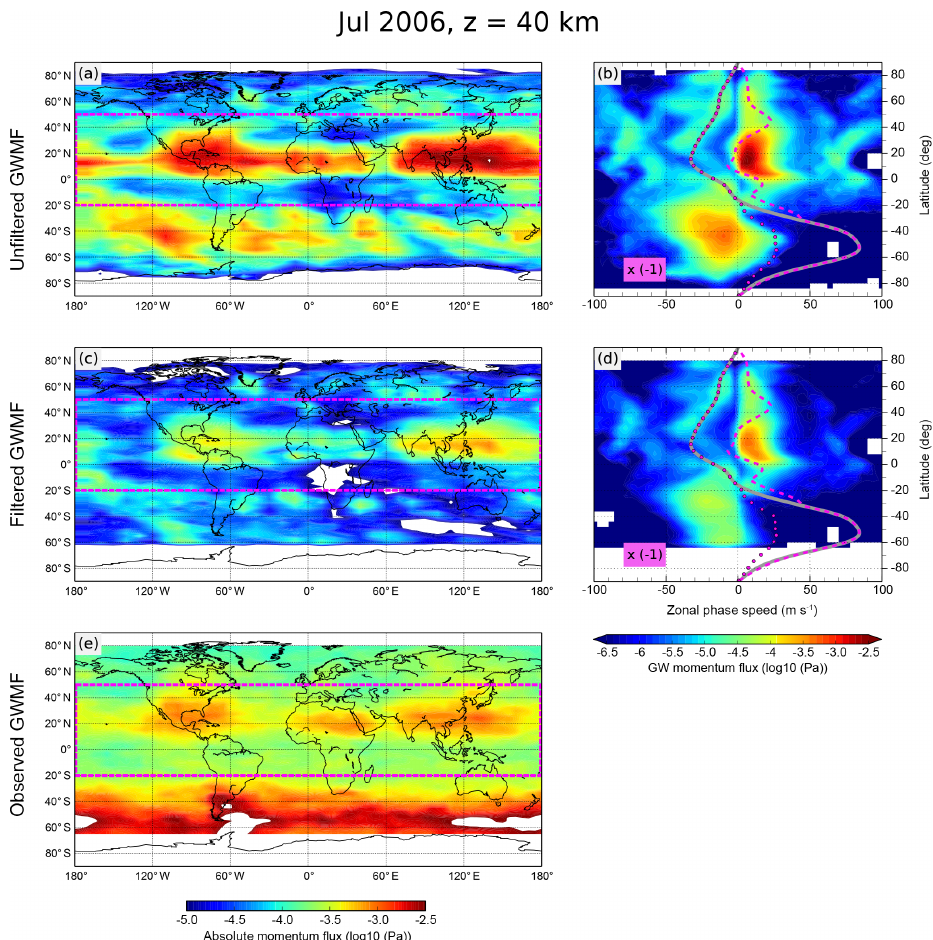
Figure 9. Horizontal distribution of (a) unfiltered absolute GWMF and (c) filtered absolute GWMF in comparison with (e) horizontal distribution of observed absolute GWMF. Panel (b) shows phase speed spectrum of unfiltered zonal GWMF (absolute values) and (d) shows phase speed spectrum of filtered zonal GWMF (absolute values). In phase speed spectra, GWMF values associated with negative values of phase speed (on the left-hand side) are multiplied with − 1. Results are shown for July 2006 at 40km altitude. Simulations were performed using MERRA data. For details see